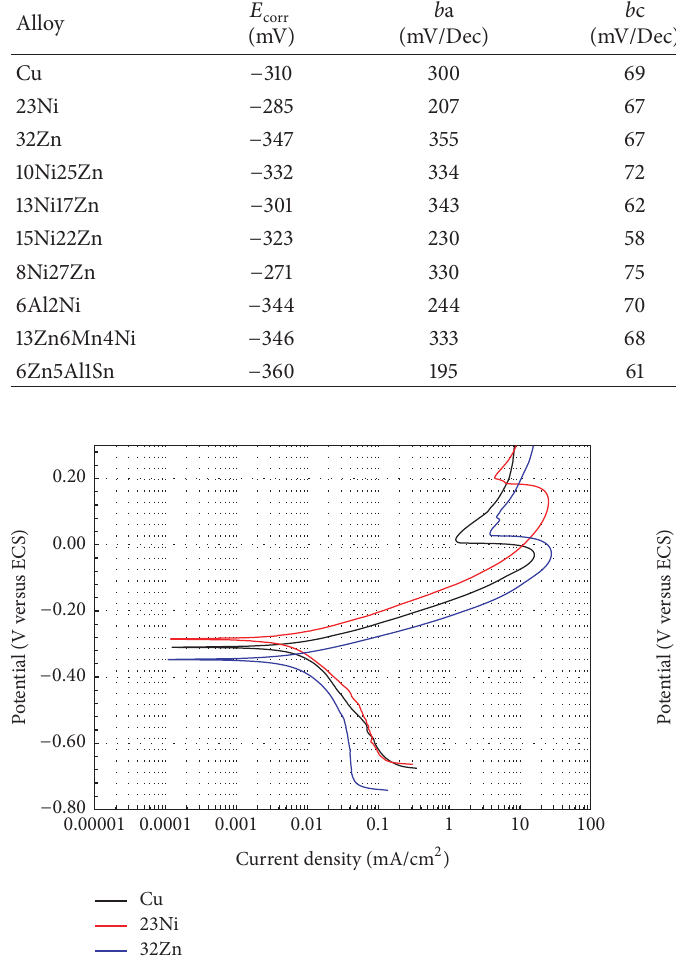
Figure 2: Polarization curves for the Cu-based ternary alloys in artificial sweat at 37 ∘ C ( dE/dt = 1.0